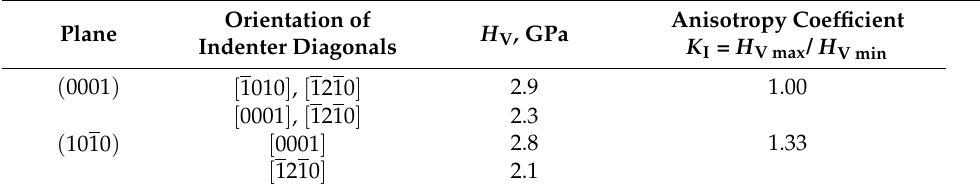
Table 1. The Vickers microhardness anisotropy for the undoped CeF 3 single crystal under the load P = 60